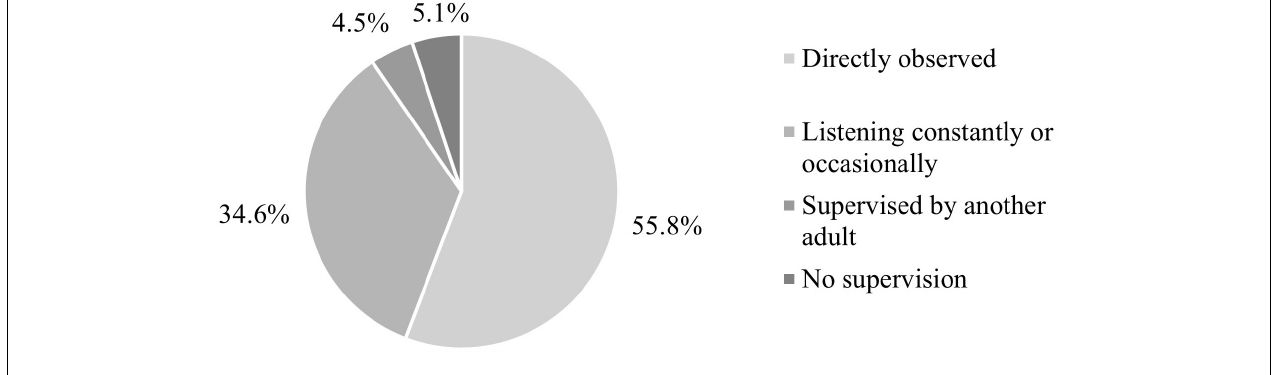
FIGURE 2 | Levels of parental